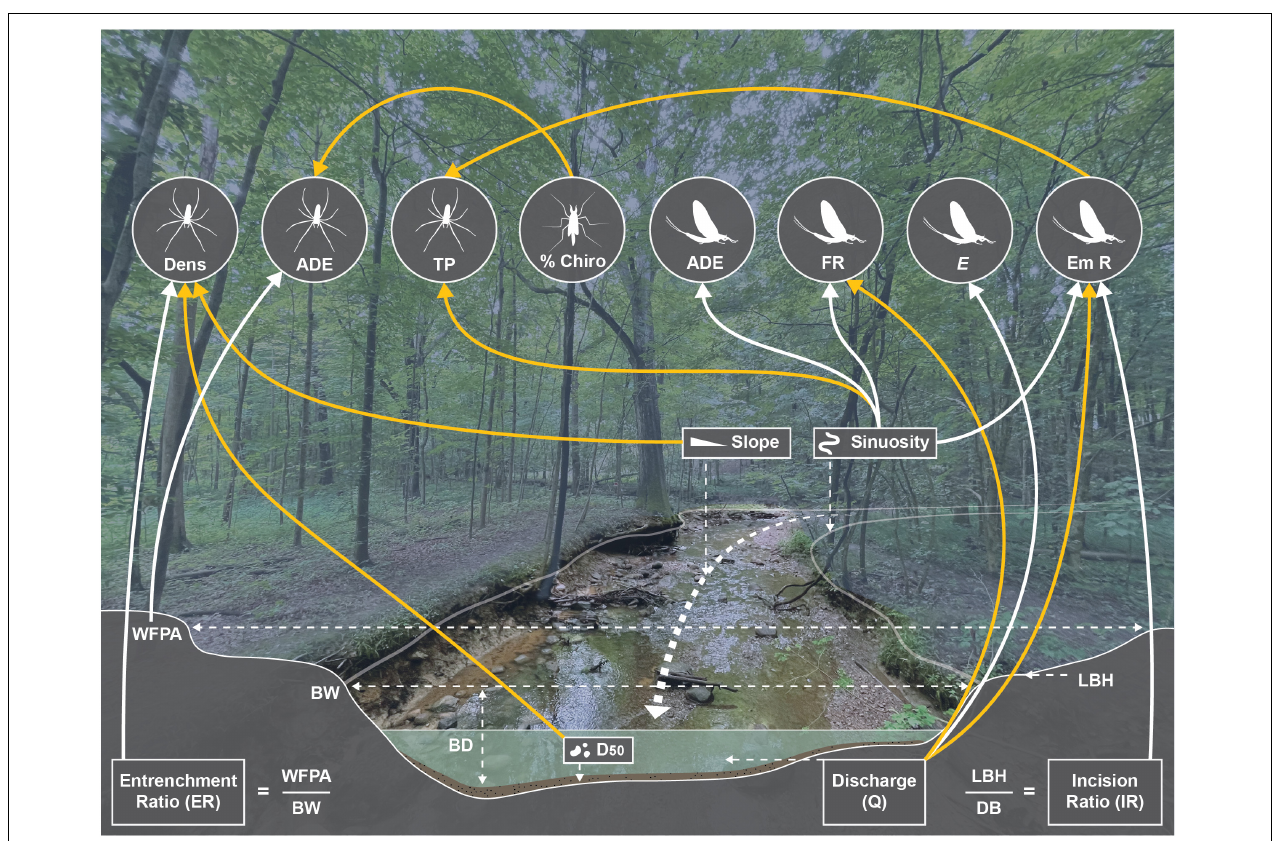
FIGURE 5 | Visual representation of key relationships among hydrogeomorphology, emergent aquatic insects, and tetragnathid spiders. Relationships derived from AICc model results ( Tables 2 , 3 ). Yellow lines indicate negative relationships, black lines indicate positive relationships. Dens, density; ADE, reliance on aquatically derived energy; TP, trophic position; Chiro, Chironomidae; FR, family richness; E , evenness; Em R, emergence rate; WFPA, width of floodplain area; BW, bankfull width; LBH, low bank height; BD, bankfull depth; D 50 , median sediment particle size. Figure by R. B.